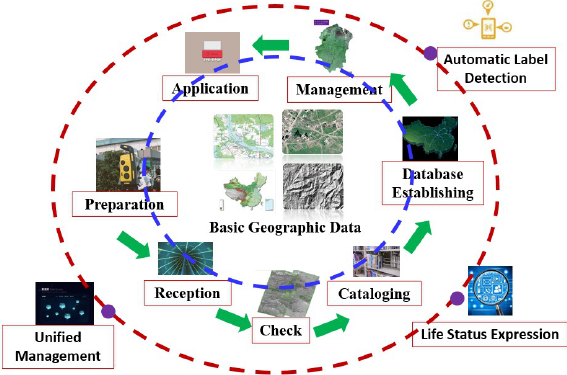
Figure 5 . Geographic data lifecycle